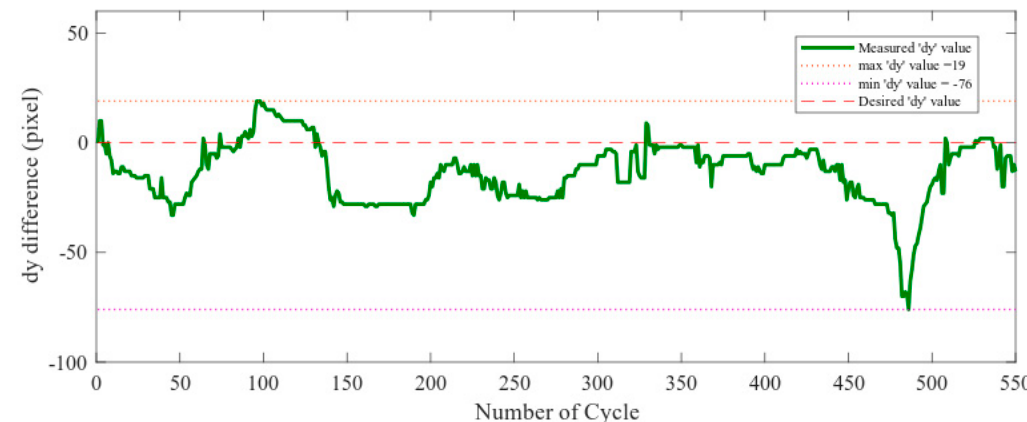
Figure 16. Distance between robot position and center-line (lateral error).